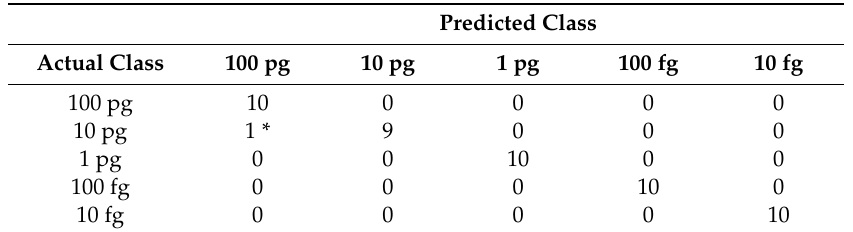
Table 6. Confusion matrix for testing the method with the SVM. The asterisk sign (*) denotes the misclassified analyte quantity for the test LFA